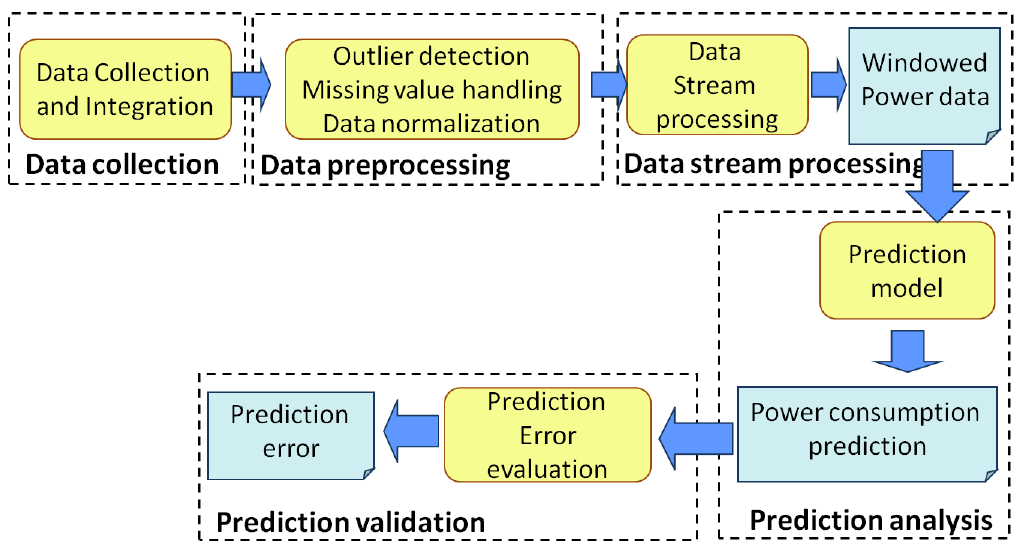
Figure 1. The scalable predictor of power consumption (SPEC)